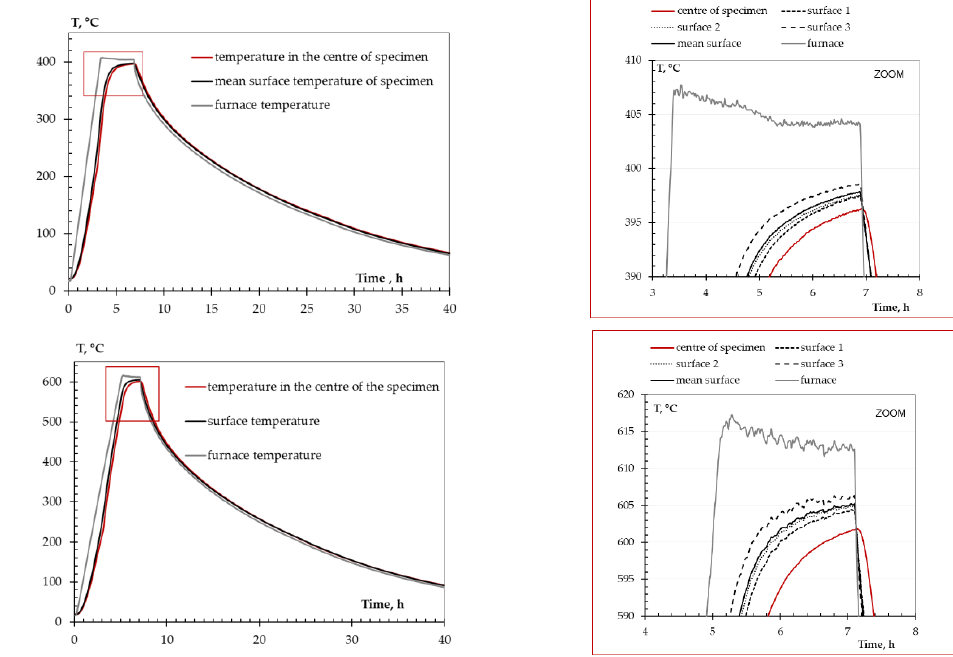
Figure A1. Temperature development for mix M11-LF15 during heating to target temperature of ( a ) 200°C, ( b ) 400°C and ( c ) 600°C.